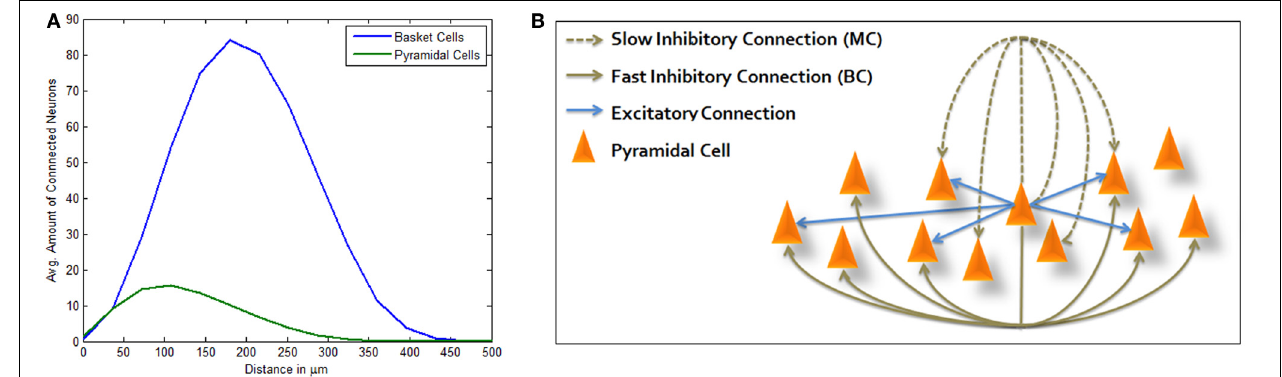
FIGURE 1 | Three-way inhibitive structure. (A) Average amount of connected PCs (green) and LBCs (blue) from a single PC per inter-somatic distance (avg. sum of neurons per distance surrounding a single PC). PC and LBC distributions and connectivity functions allow for Mexican hat shaped excitation, as connected PCs are generally closer